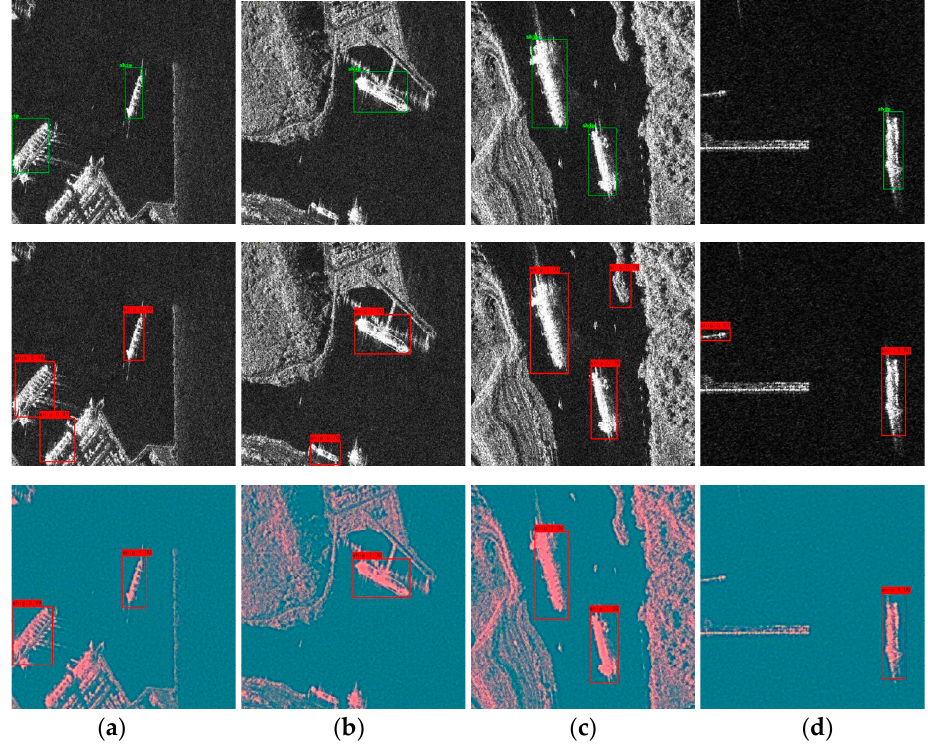
Figure 11. Ship detection ground truth and different precision results for YOLO-V4-tiny and YOLO-V4-light. ( a – d ) Comparison of the detection results of different algorithms in different scenarios.